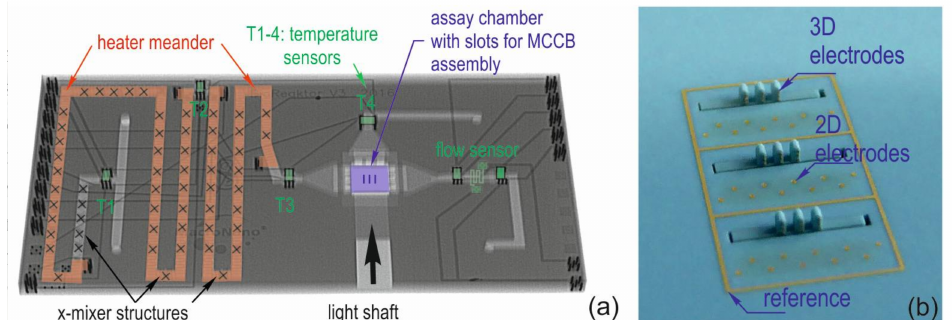
Figure 1. ( a ) Ceramic bio-reactor. The colored X-ray image makes it possible to view the integrated mixer, temperature control and flow monitoring. The base plate consists of glass and is mounted with epoxy at the bottom, next device generation with integrated 3D sensors is equipped with a ceramic base plate and slots for ceramic contact board assembly, indicated by the blue lines; ( b ) three miniaturized ceramic circuit boards, assembled perpendicular through slots of the ceramic base plate (LTCC test